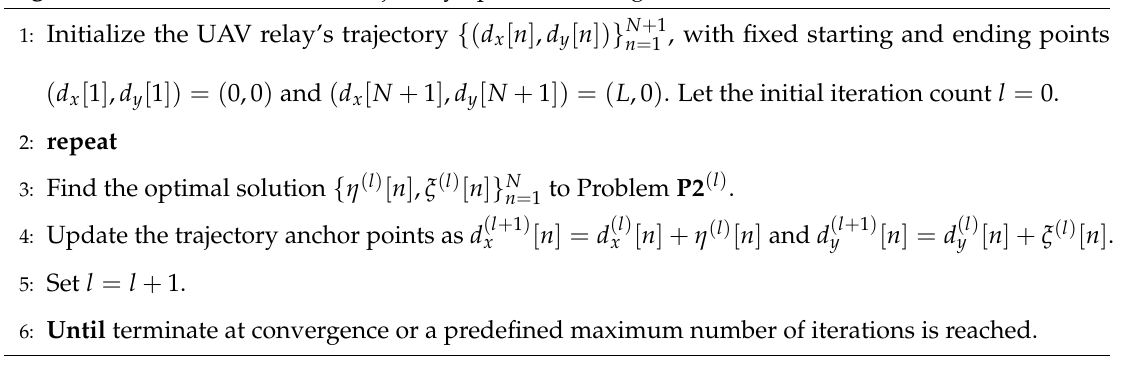
Algorithm 1 The iterative UAV trajectory optimization algorithm